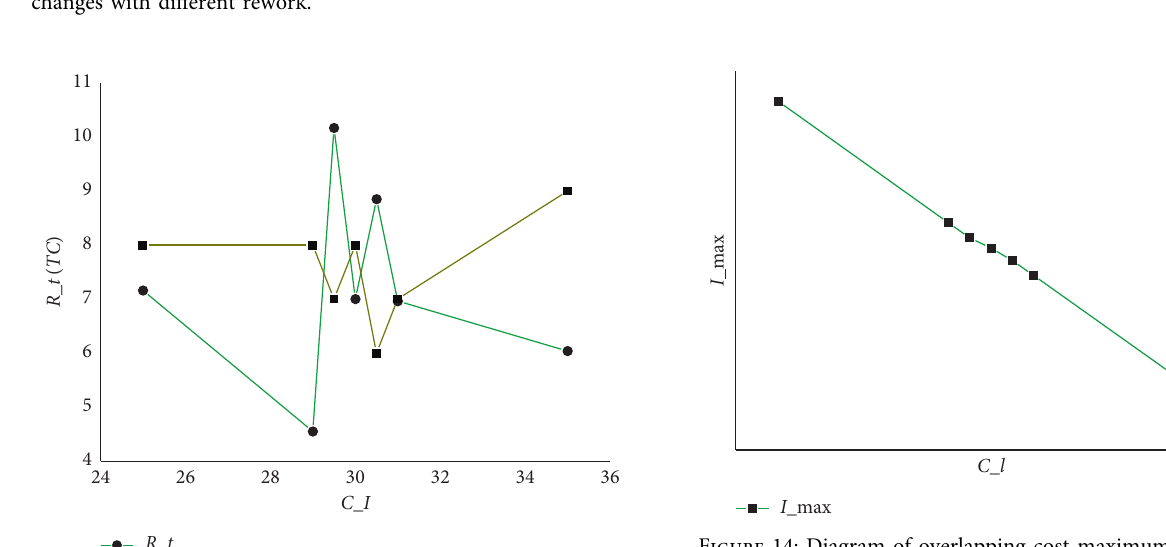
Figure 11: Diagram of rework time and number of communication changes with different rework.